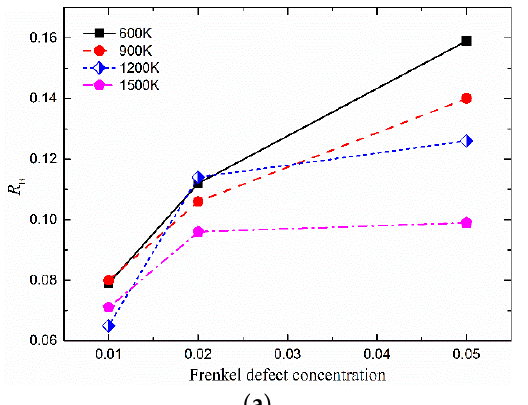
( b ) Figure 9. R G as a function of the concentration of Frenkel defects ( a ) and antisites ( b ) at different temperatures. ( a ) ( b ) Figure 10. R Y as a function of the concentration of Frenkel defects ( a ) and antisites ( b ) for different temperatures. Figures 8a, 9a, and 10a illustrate that in low concentration ranges the difference among the percentages of reduction in the elastic modulus for different temperatures is small. However, this difference is more evident at higher defect concentrations. In addi- tion, this is not as significant for antisite defects as it is for Frenkel defects. The R of the elastic modulus due to antisite defects is smaller than that by Frenkel defects. For 5%